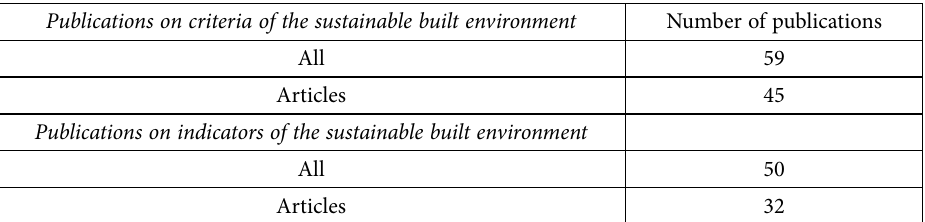
Table 1. Publications on the topic of the sustainable built environment in the Web of Science database Publications on criteria of the sustainable built environment Number of publications All 59 Articles 45 Publications on indicators of the sustainable built environment All Articles